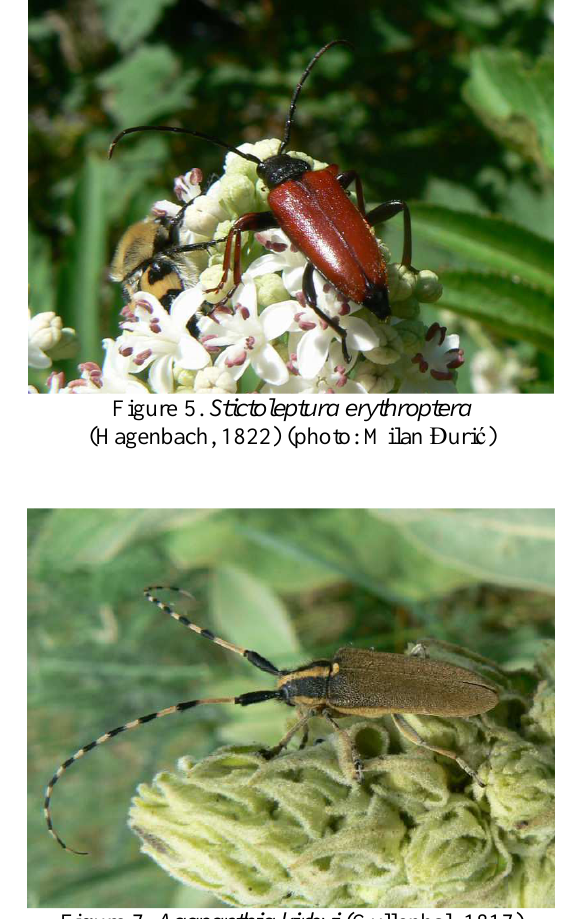
Figure 8. Cortodera flavimana flavimana (Waltl, 1838) (photo: Milan Đ uri ć